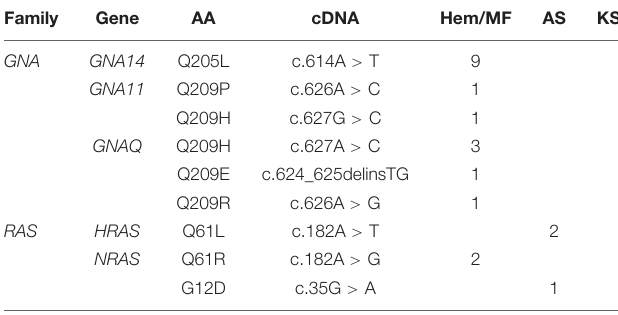
TABLE 2 | Mutations identified in vascular tumors and malformations.